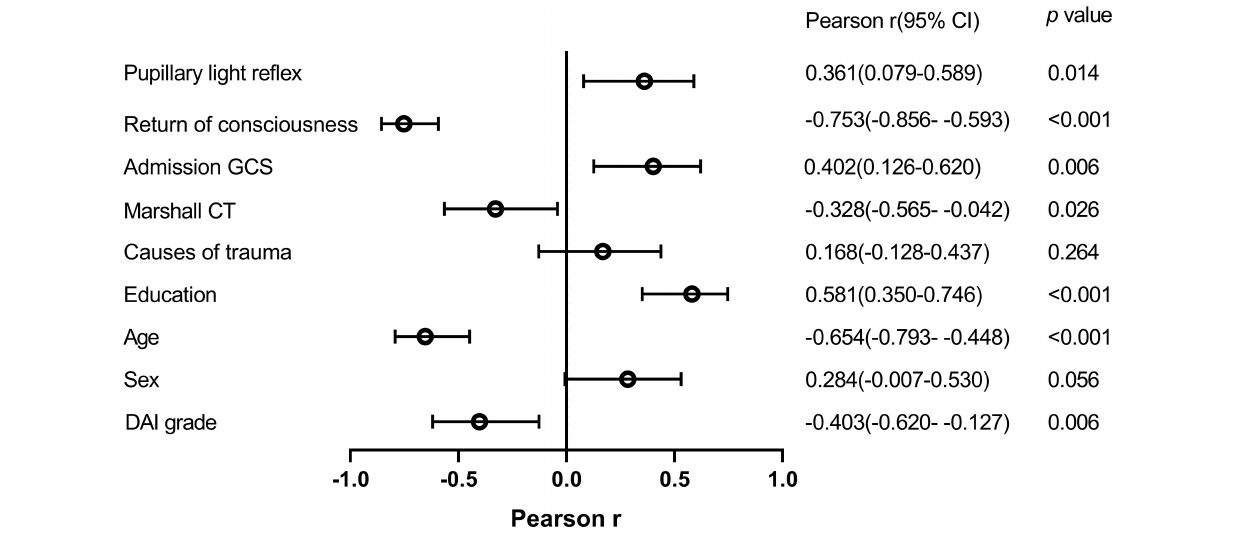
risk factors was basically consistent for the cognitive function of TBI patients and DAI patients with favorable